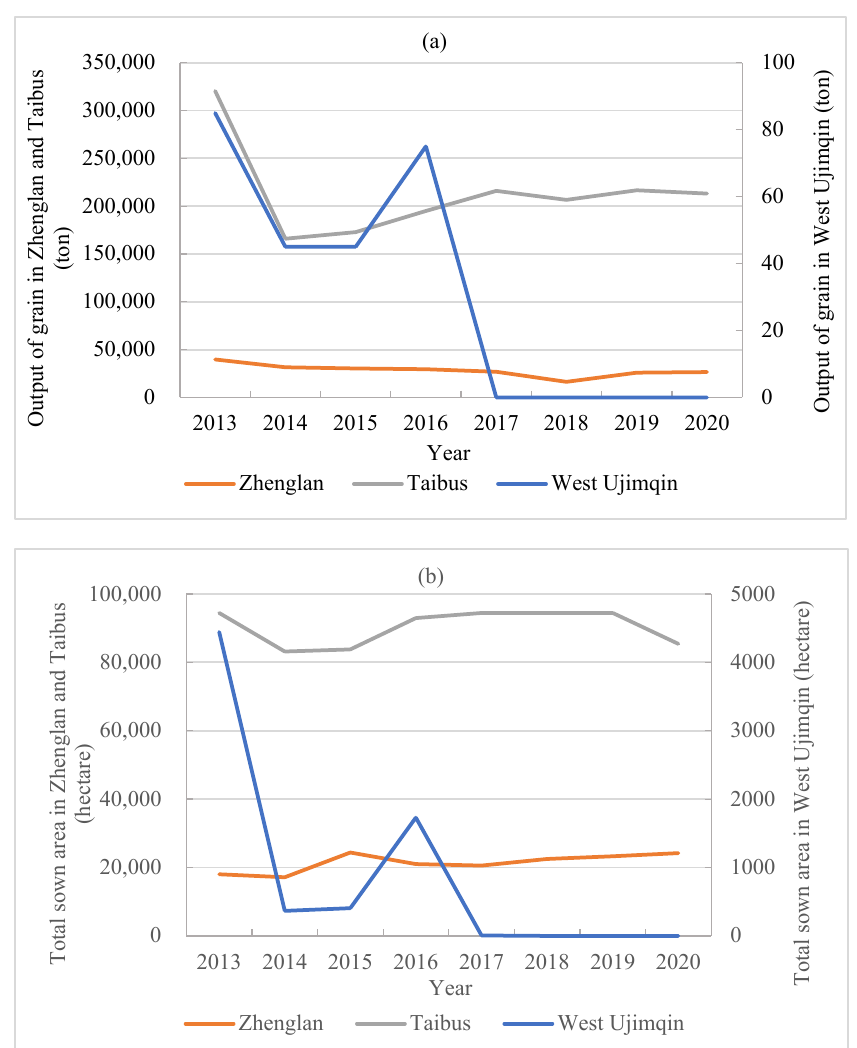
Figure A2. Annual production of meat in three Mongolian banners.